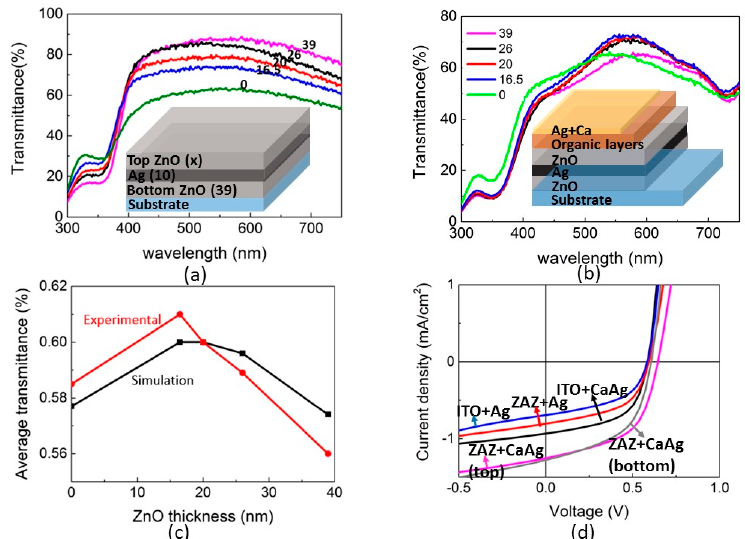
Figure 6. ( a ) Transmittance spectra of ZAZ electrodes with various thickness of the top ZnO layer. The inset shows the structure of the ZAZ electrode. ( b ) Transmittance spectra of the transparent solar cells with various thickness of the top ZnO layer. The inset shows the device structure of the transparent solar cells. ( c ) Experimental and simulated results of the average transmittance of the transparent solar cells with various thickness of the top ZnO layer. ( d ) J-V curves of the transparent solar cells with different bottom and top electrodes. Table 1. Device performance of the transparent solar cells with various electrodes. Bottom/Top Electrode